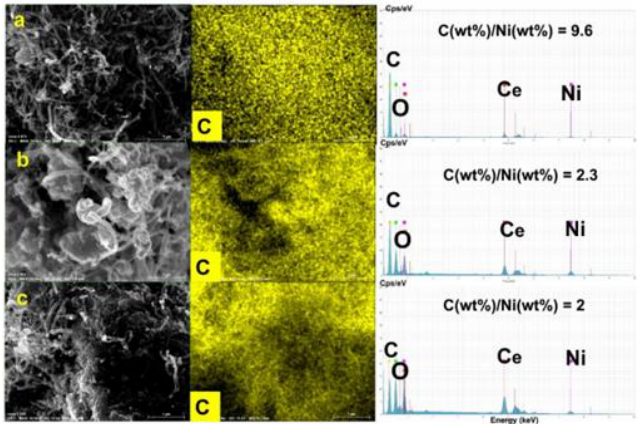
Figure 7. SEM analysis on spent catalysts: ( a ) used NiCe (i); ( b ) used NiCe (c); ( c ) used NiCe (n).